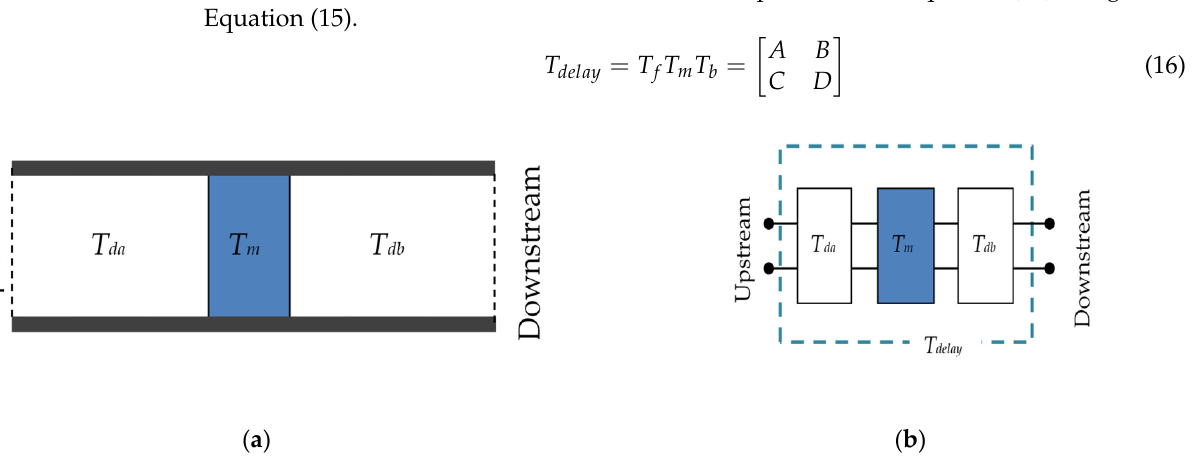
Figure 6. Acoustic elements of the delay tube: ( a ) acoustic elements of the delay tube and ( b ) equivalent circuit of the delay